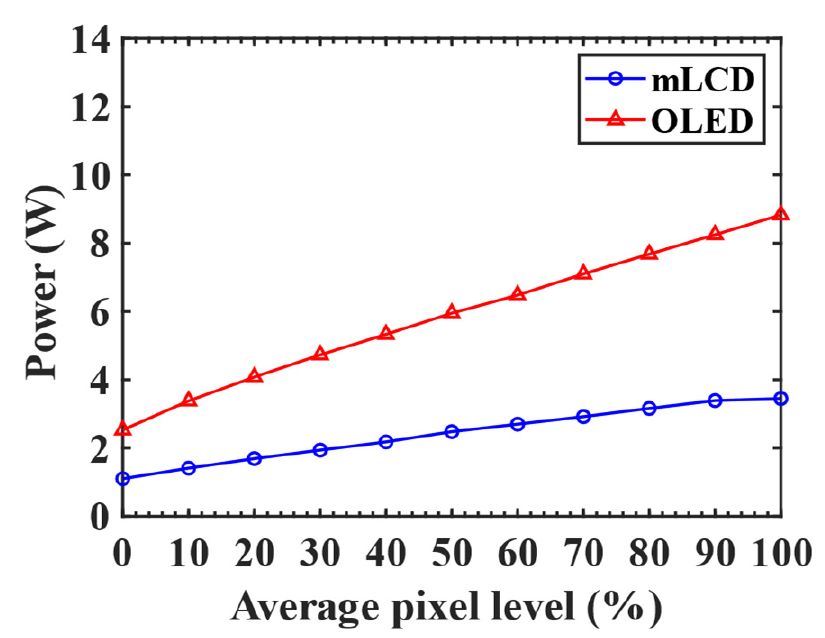
Figure 6. Power consumption as a function of the APL for the 15.6-inch mLCD and OLED display